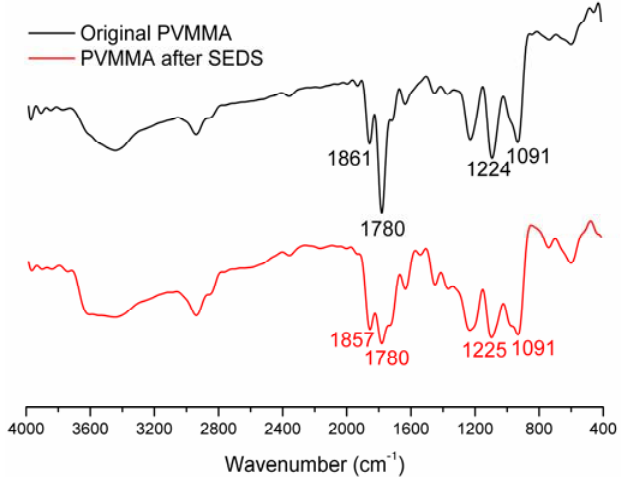
Figure 3. FTIR spectra of original PVM/MA and PVM/MA nanoparticles prepared under the optimized operating parameters (concentration: 1% wt/v, flow: 1.5 mL min − 1 , solvent/nonsolvent: